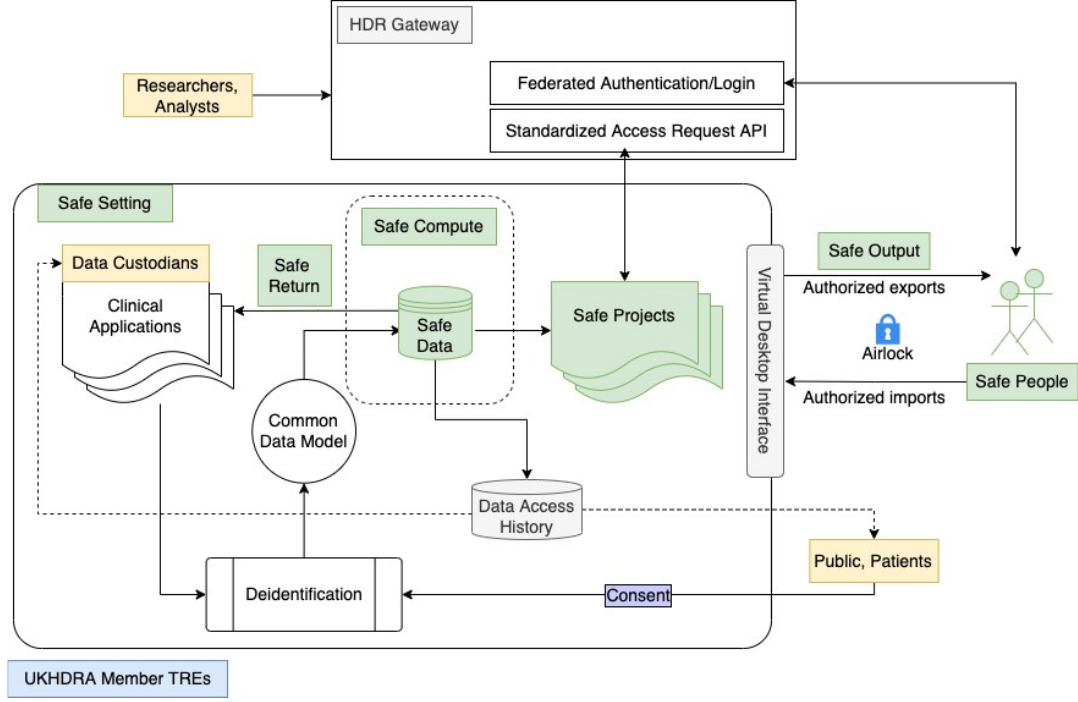
Figure 1. Overall diagram of a TRE and its integration with the HDR Gateway.